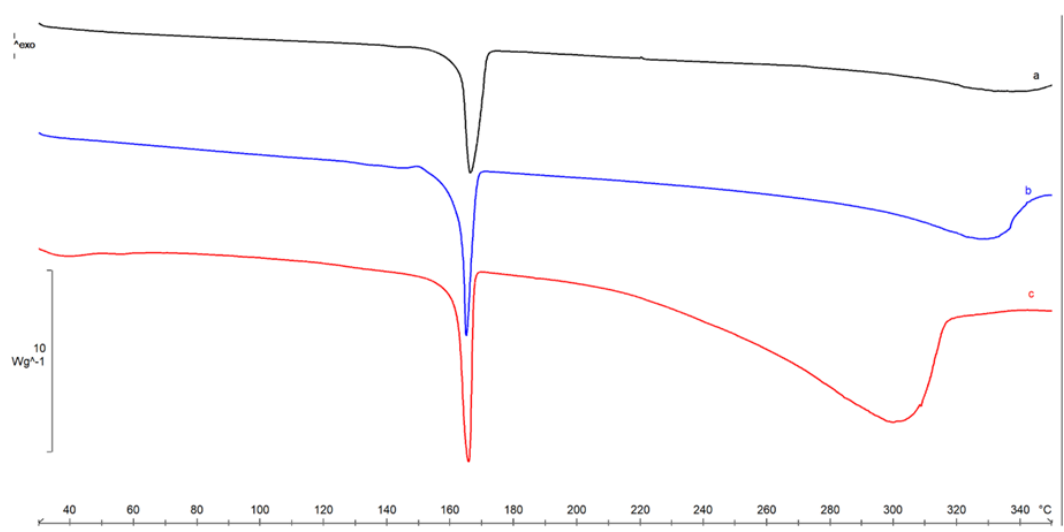
Figure 2. DSC profiles of Lyosecretome batches 1, 2, and 3 (curves a, b, and c).